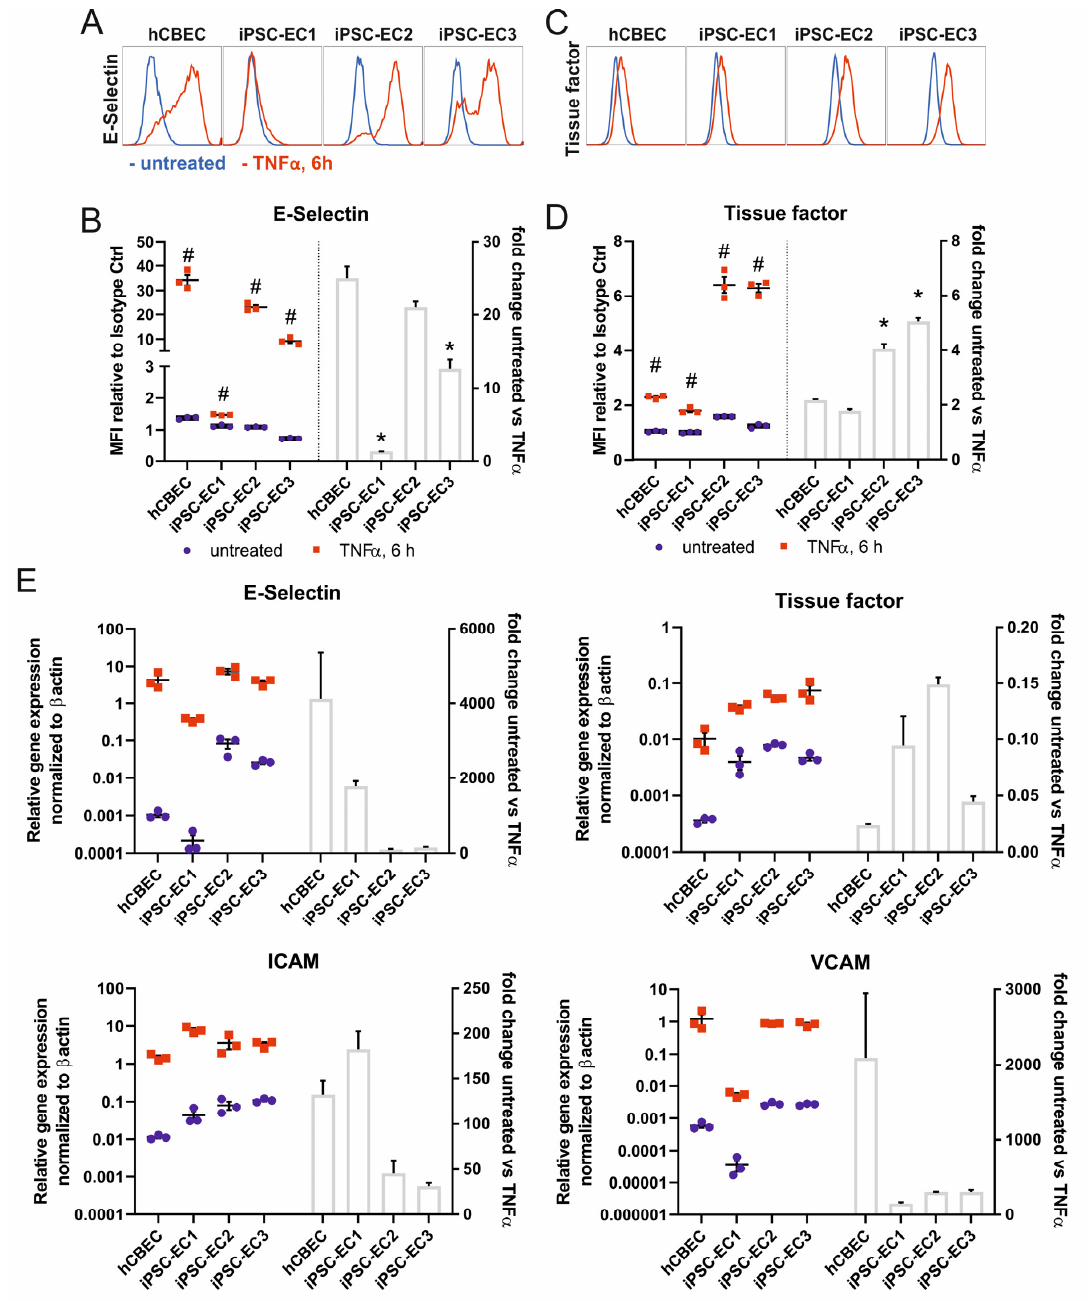
Figure 2. iPSC-derived ECs seeded on fibronectin-coated PMP membranes show upregulation of markers of inflammation and hemostasis upon stimulation with 10 ng/mL TNF α for 6 h. ( A ) Flow cytometry analysis of E-selectin (CD62E) surface expression. Representative histograms of untreated (blue histograms) vs. TNF α -treated (red histogram) ECs. ( B ) Quantification of mean fluorescence intensities (MFI, represents geometric mean normalized to corresponding isotype controls) of E-selectin expression with flow cytometry (left) and calculated fold-change of untreated vs. TNF α -treated ECs (right). ( C ) Representative histograms of flow cytometry analysis ECs for tissue factor (CD142) surface expression. ( D ) Quantification of mean fluorescence intensity (MFI) of tissue factor surface expression with flow cytometry (left) and calculated fold-change of untreated vs. TNF α -treated ECs (right). ( E ) qPCR quantification of activation-relevant marker genes E-selectin, tissue factor, ICAM-1 and VCAM-1. The mRNA expression was normalized to the expression of β -actin using the Δ Ct-method. All data are representative of 3 technical replicates for each EC type. Reported values are given as means ± standard error of mean. Differences were considered significant at p < 0.05. # Significantly different TNF α -treated vs. untreated. * Fold change significantly different vs. hCBECs.